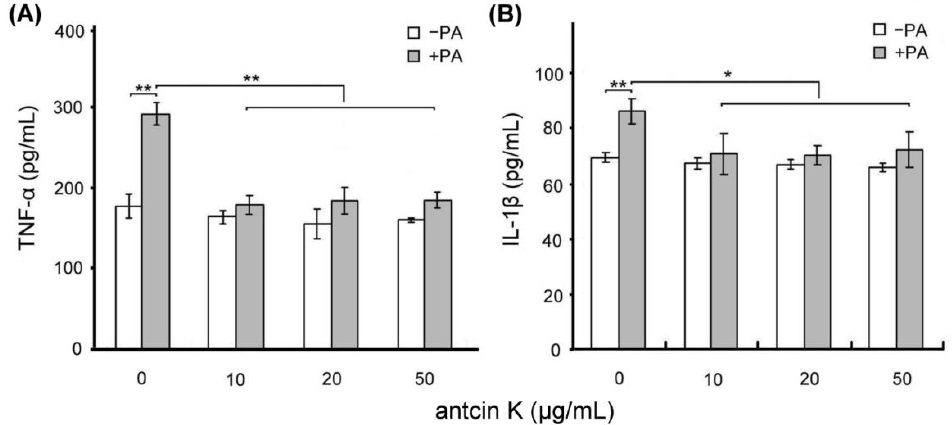
Figure 5. Antcin K treatments effectively alleviated inflammation of palm oil-treated vascular endothelial cells. Comparison of the quantified expressions of the inflammatory markers TNF- α ( A ) and IL- 1β ( B ) of vascular endothelial cells with and without 0.75 mM palm acid oil (PA) treatment, and with antcin K treatments at 0, 10, 20, and 50 μ g/mL ( n = 3 for each group; values are presented as mean ± SEM, ** p < 0.01, * p < 0.05, two-way ANOVA followed by the Student – Newman – Keuls multiple comparison post hoc test).